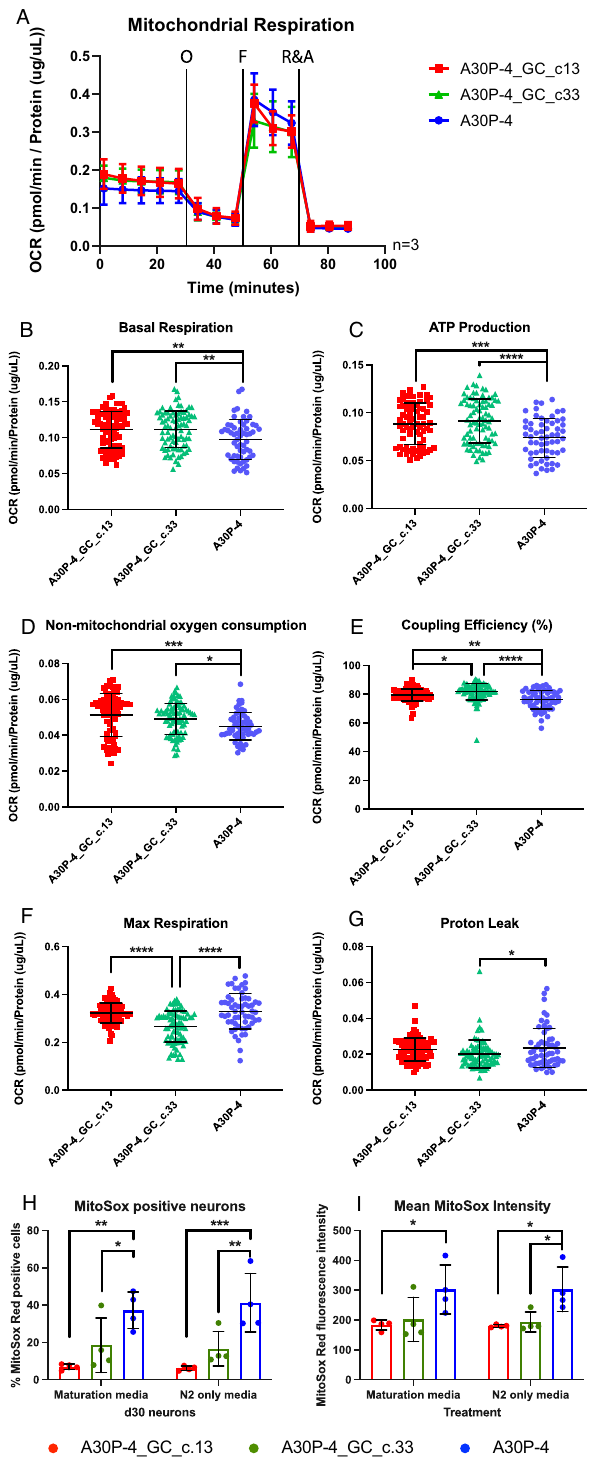
Figure 3. Mitochondrial dysfunction in neurons carrying the p.A30P SNCA mutation. ( A ) Bioenergetic profile showing oxygen consumption rate (OCR) of patient-derived neurons following a mitochondrial stress test under basal conditions and following the treatments of the ATP synthase inhibitor oligomycin (O, 1 µM), the oxidative phosphorylation uncoupler FCCP (F, 500 nM), and the electron transport chain inhibitors rotenone (Complex I) and antimycin A (Complex III) (R&A, 10 µM). The cumulative OCR profile is shown in ventral midbrain neurons differentiated for 30 days (n = 3). The rates of ( B ) Basal Respiration, ( C ) ATP production, ( D ) Non-mitochondrial respiration, ( E ) Coupling efficiency, ( F ) Maximum Respiration and ( G ) Proton Leak are shown. Each data point refers to individual values taken from a minimum of 12 replicates from 3 independent biological replicates. Mitochondrial reactive oxygen species measured by flow cytometry of ( H ) MitoSOX Red positive cells and ( I ) MitoSOX Red mean fluorescence intensity in typical “maturation” culture medium or with N2 media (without B27, trophic factors and antioxidants) for 4 h (n = 4). Each data point refers to 4 independent biological replicates. For all statistical analyses, an ordinary one-way ANOVA was performed using the Tukey post-hoc multiple comparison test. All graphs were plotted as mean ± SD. *p < 0.05, ** p < 0.01, ***p < 0.001 ****p <